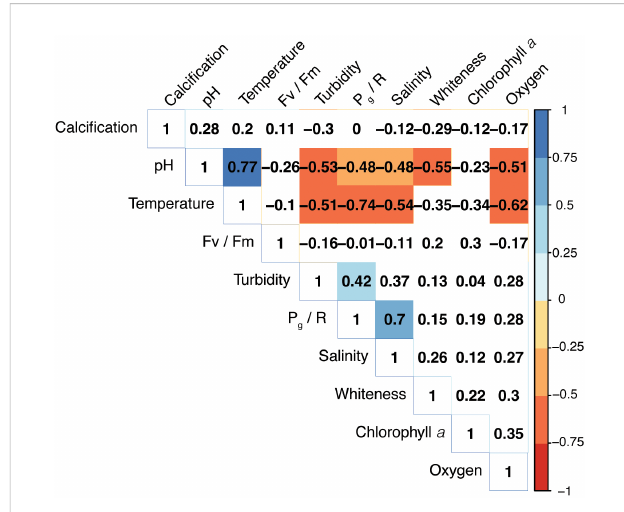
FIGURE 5 Correlogram of environmental variables and coral metabolic parameters based on Spearman ’ s correlation coef fi cients. Color intensity is proportional to the strength of the correlation. Only signi fi cant correlations ( p < 0.05) are highlighted. The matrix was reordered using a hierarchical clustering.